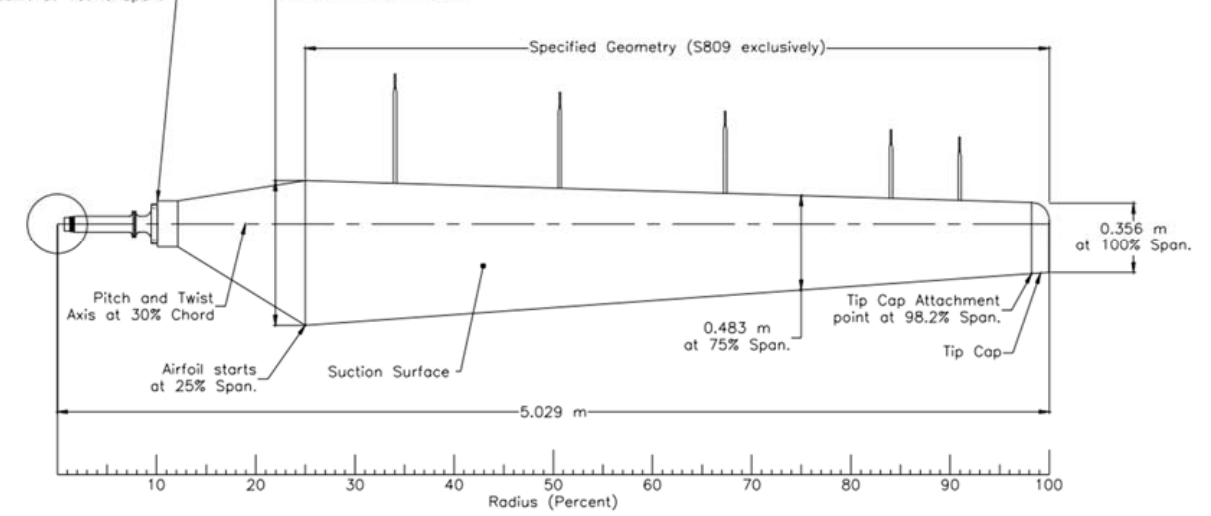
Figure 6. NREL Phase VI wind turbine blade dimensions [12].